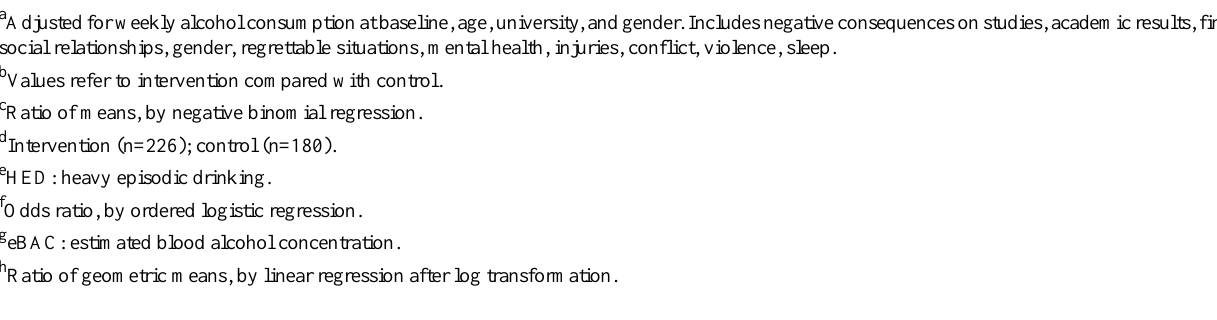
Figure 2. Mean total weekly consumption reported at the different attempts to collect follow-up